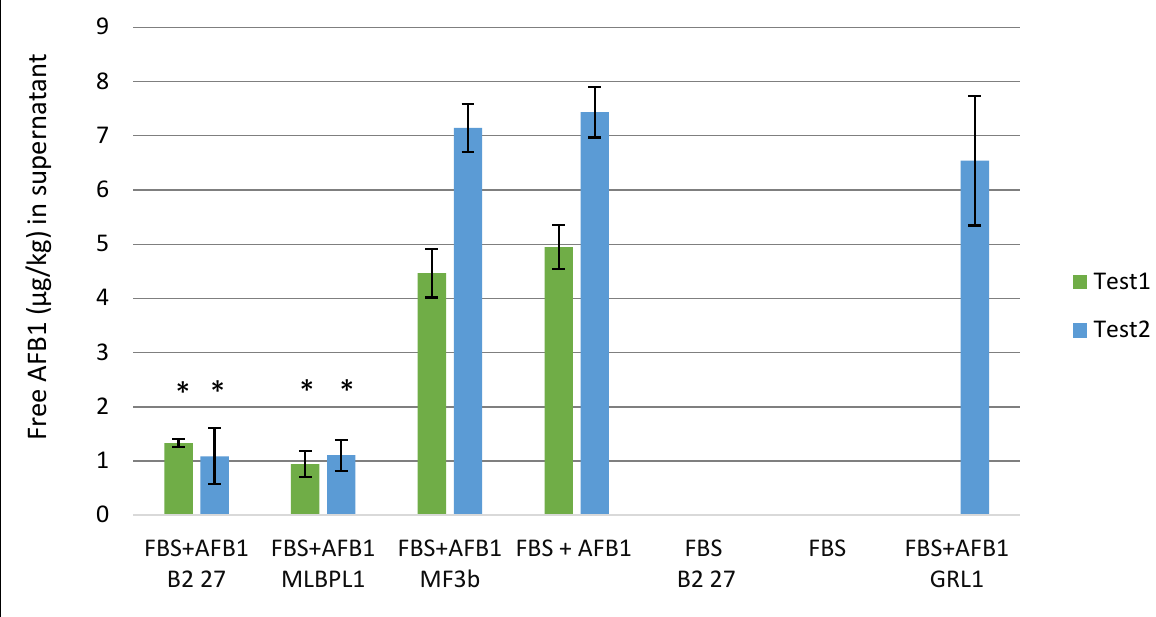
Figure 1. Concentration of free AFB1 (µg/kg) in supernatant fractions of AFB1 binding experiments. The columns show an average of three parallel cultivations, and vertical bars represent standard deviation of the mean. With the exception of L. brevis GRL1, the experiments were performed as two independent tests. Statistically significant differences ( p < 0.05) with respect to background AFB1 binding without LAB inoculation (FBS + AFB1) are denoted with an asterisk *.